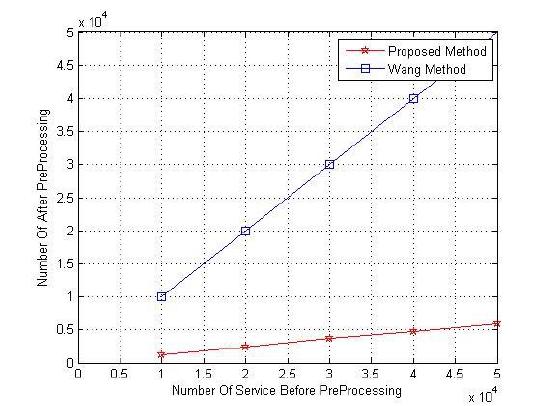
Figure 8. Pre-processing effect on the number of